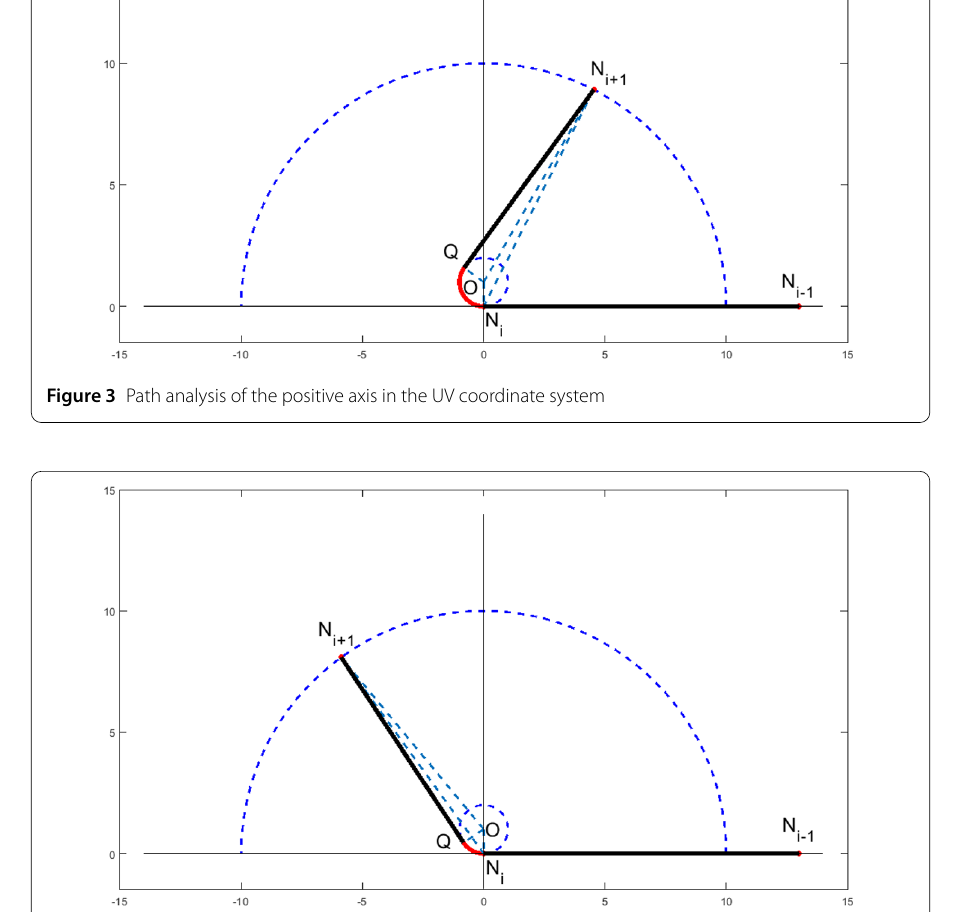
Figure 4 Analysis of the path of the anti-axis direction in the UV coordinate